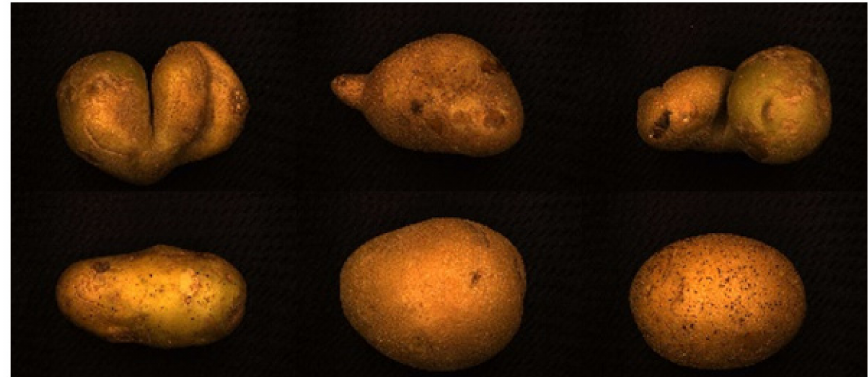
Figure 1. Various regular and irregular potatoes.